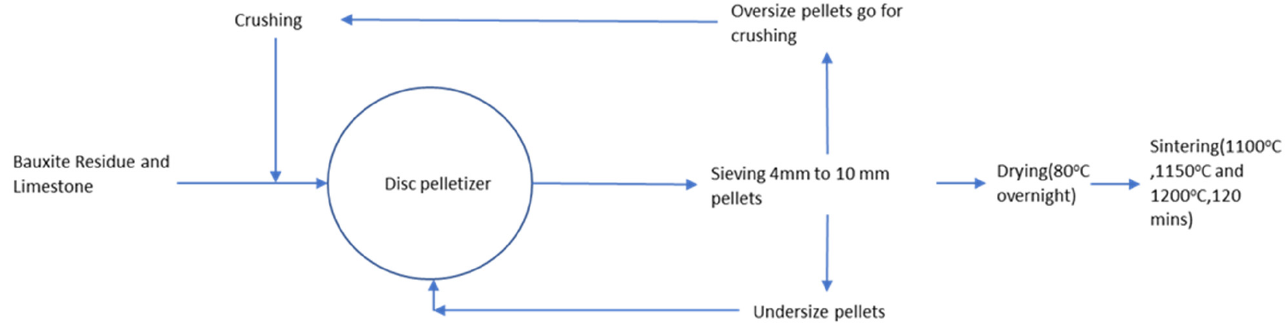
Figure 1. Overall pelletization and sintering process.